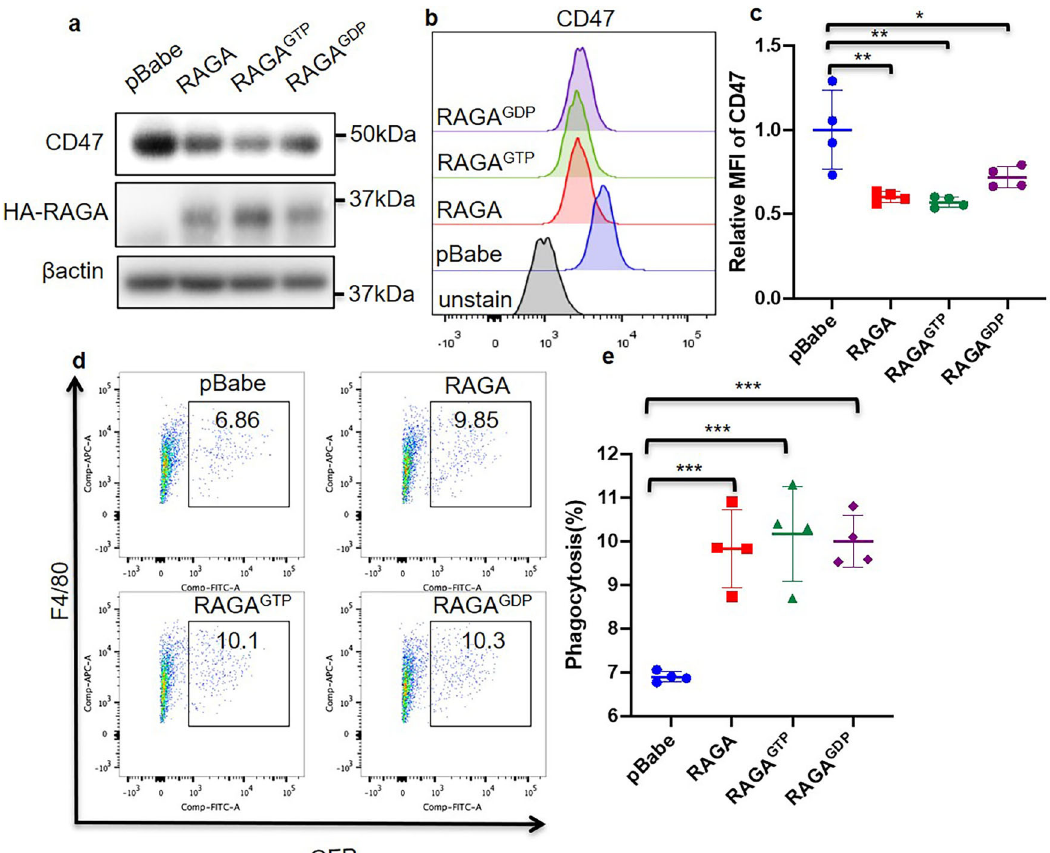
Fig. 3 Both RAGA GTP/GDP binding states inhibit CD47 and promote phagocytosis. a Immunoblot analysis of indicated proteins in pBabe empty vector, wild type or mutant RAGA overexpressed A549 cells. b Representative fl ow cytometry of CD47 protein expression on the cell surface. c Statistical analysis of cell surface CD47 expression ( n = 4 per group). d Representative fl ow cytometry analysis of in vitro phagocytosis in macrophage and GFP-labeled A549 coculture system. Numbers in the outlined areas indicate the percentage of macrophages with phagocytosis. e Statistical analysis of the percentage of phagocytic macrophages cocultured with empty vector, wild type or mutant RAGA overexpressed A549 as in ( d ) ( n = 4 per group). Data were from two or three independent experiments. Statistical data were presented as mean ± SD. P < 0.05 is considered statistical signi fi cance. * indicates P < 0.05; **indicates P < 0.01; and *** indicates P <